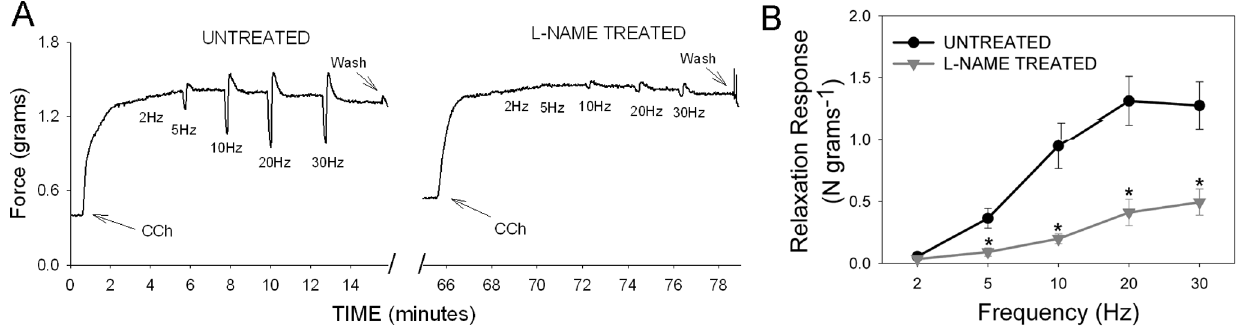
Figure 2. Effect of L-NAME on nerve-mediated relaxation in mouse gastric fundus. (A) Representative tracings before (untreated) and after L-NAME treatment showing pre-contraction induced by carbachol (arrows) followed by relaxation due to increasing frequencies of stimulation in a WT mouse. Note the relaxation response during the stimulation is followed by an off-contraction. (B) Relaxation response to EFS after L-NAME treatment (gray triangles) was significantly lower than baseline relaxation response (black circles). [n=5; *=significantly lower than baseline response; p , 0.0002 by paired t test].